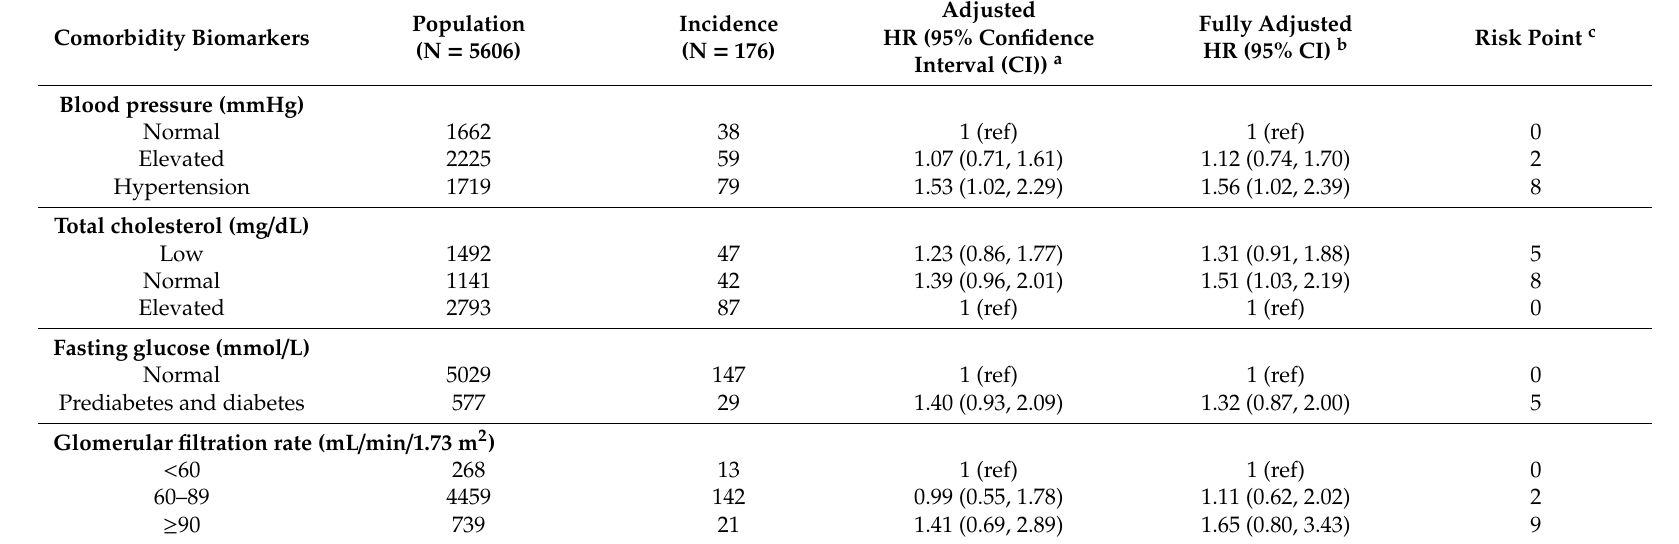
Table 3. Comorbidity biomarkers and the risk of cancer